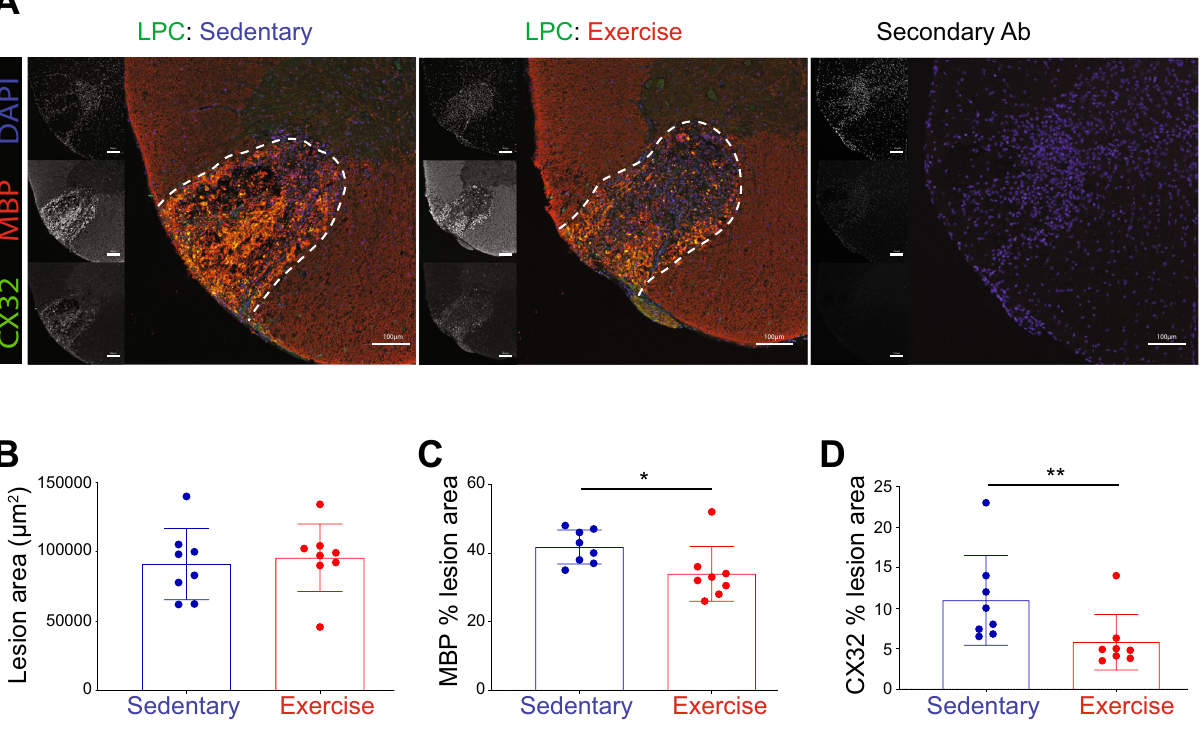
Figure 7. Immunofluorescence microscopy of LPC mice validation of shotgun proteomics analysis. ( A ) Representative images of LPC mice from the sedentary control, exercising animals, and secondary control for connexin-32 (CX32), and myelin (MBP). Scale bar denotes 100 μm. ( B ) Quantification of lesion area. ( C ) Quantification of percent of lesion that is MBP-positive. * p < 0.05 . ( D ) Quantification of percent of lesion that